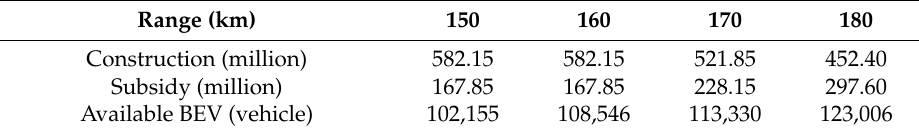
Figure 15. The results under different endurance ranges and subsidies. Table 3. The best arrangements of the budget under each endurance range.